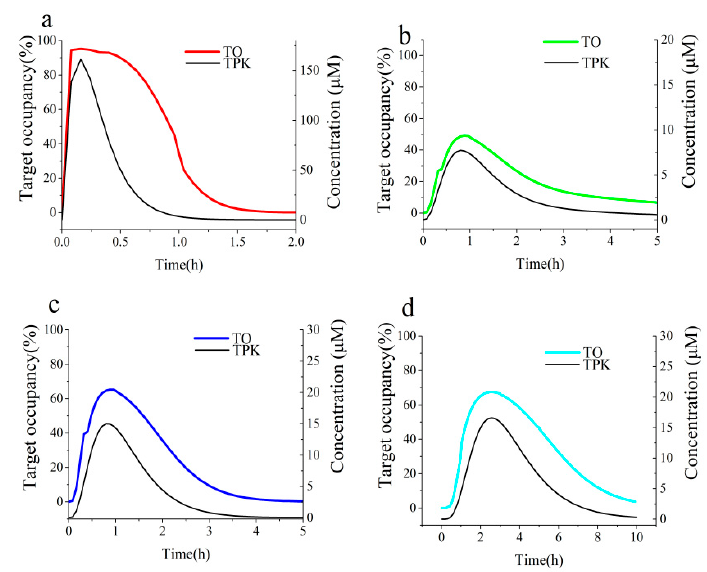
Figure 8. Simulations of the time course of AGH engagement by ECG in the UWLs of the four different intestinal segments in rat with BK-TPK model (a) duodenum, (b) jejunum, (c) ileum, (d) colon. Black solid lines represent TPK concentration-time profiles; red, green, blue and cyan solid lines represent TO time course profiles.